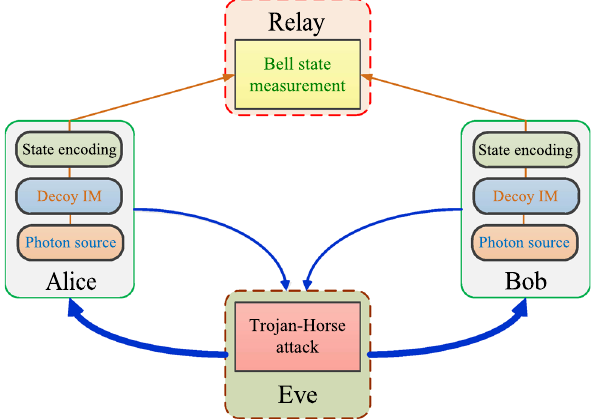
Figure 1. Each of Alice and Bob uses a photon source to prepare phase-randomised WCPs. Decoy states are generated by means of an intensity modulator (Decoy IM). The bit and basis information of the pulses are encoded with a state encoding setup (Encoding PM). The relay is supposed to perform a Bell state measurement on the incoming pulse pairs. In a THA, Eve actively sends bright light pulses (thick blue arrows) into Alice’s and Bob’s devices to trigger the emission of side-channel signals. Then, Eve measures the back-reflected light (thin blue arrows) to extract information about Alice’s and Bob’s internal settings. Note that since the relay is untrusted (i.e., it can be even Eve), in this figure we consider that it is the relay who performs the